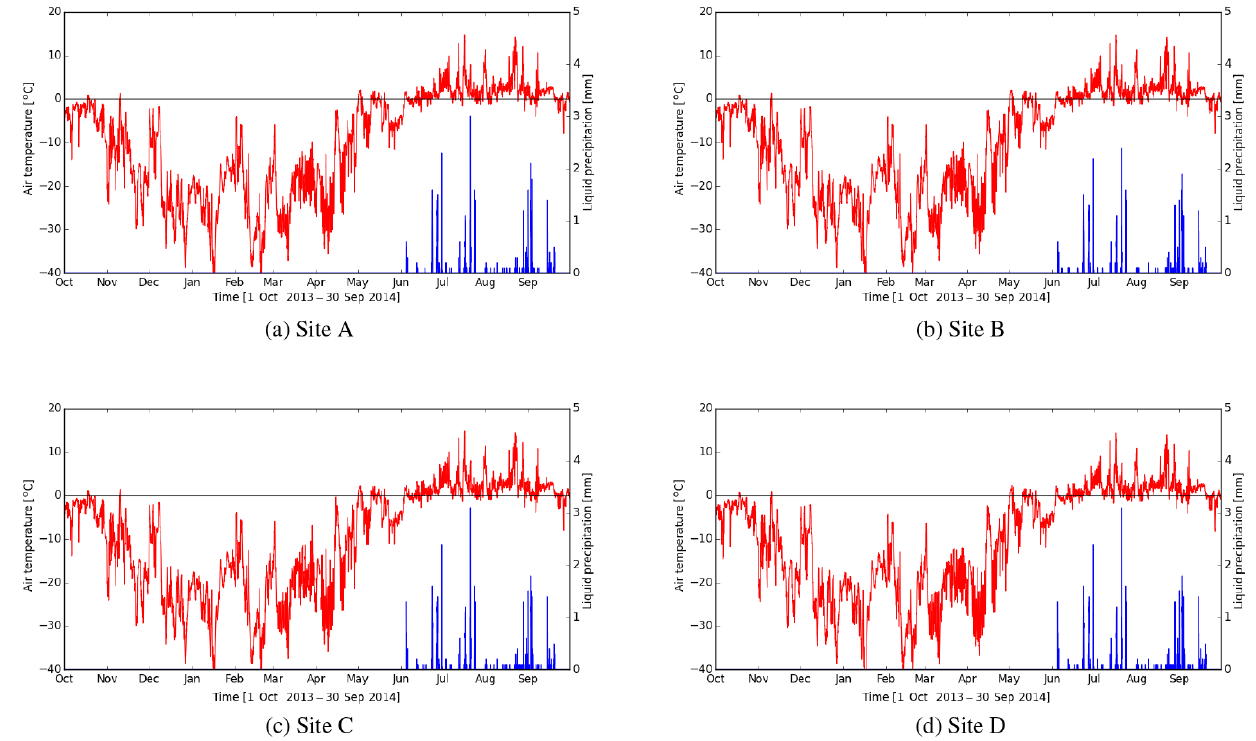
Figure C1. Meteorological conditions at study sites. Red lines: hourly air temperature, blue histograms: hourly summertime liquid precipi-